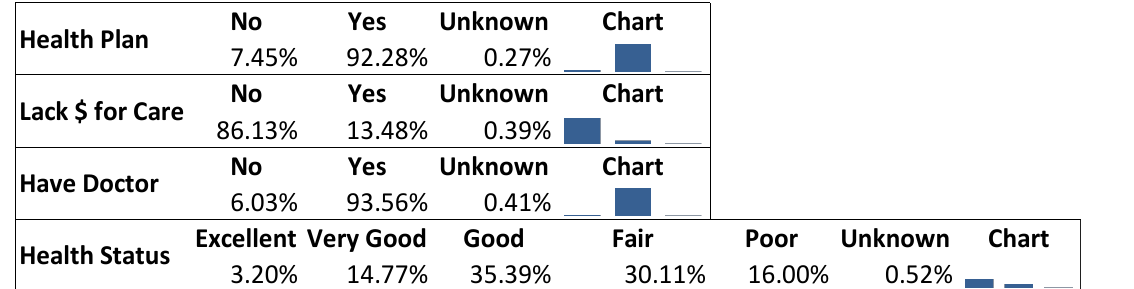
Figure 5. The marginal distributions for health status variables.